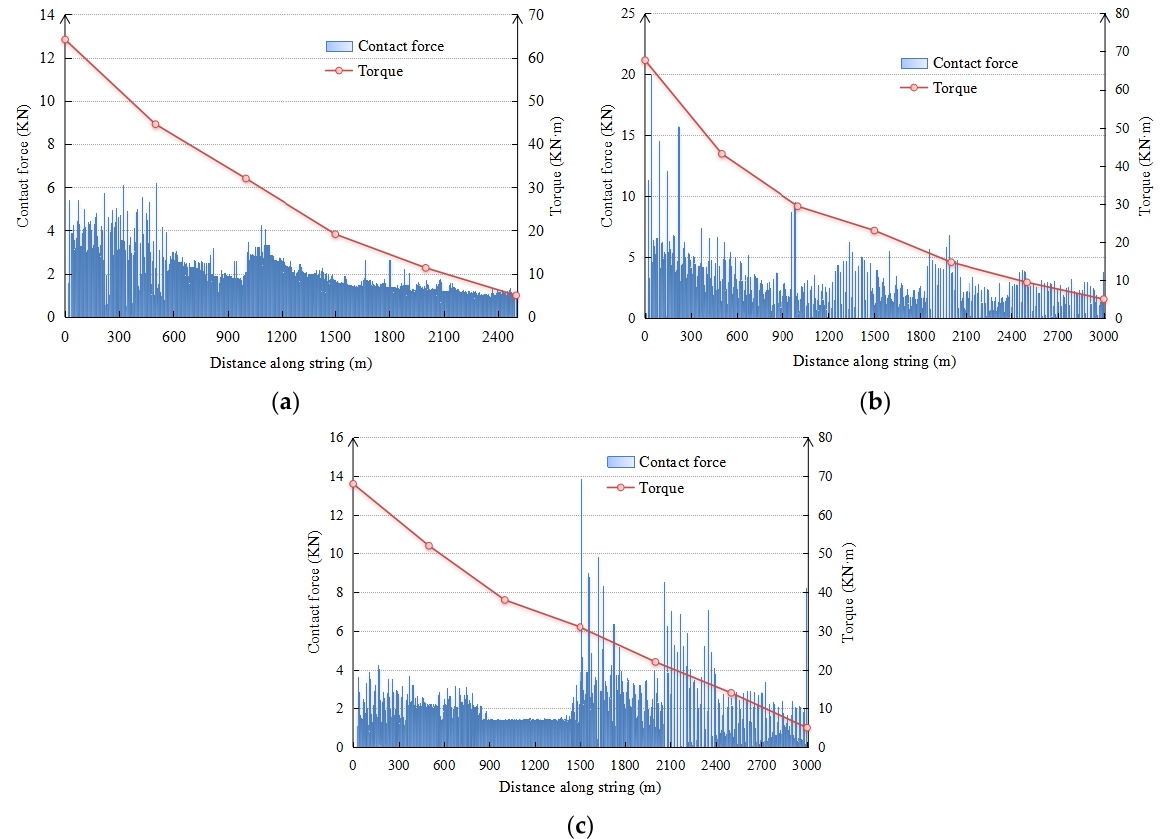
Figure 15. The contact force distribution and torque distribution of DS. ( a ) The first stage reaming. ( b ) The second stage reaming. ( c ) The third stage reaming.